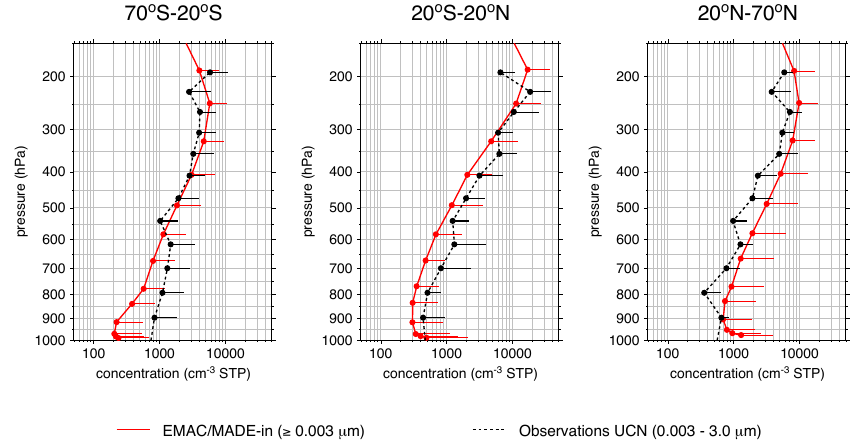
Fig. 7. Vertical profiles of the mean aerosol number concentration (converted to STP conditions: 273K, 1013hPa) from measurements by Clarke and Kapustin (2002) taken with an UCN counter over the Pacific Ocean and corresponding model values. For clarity, only positive standard deviations are shown.